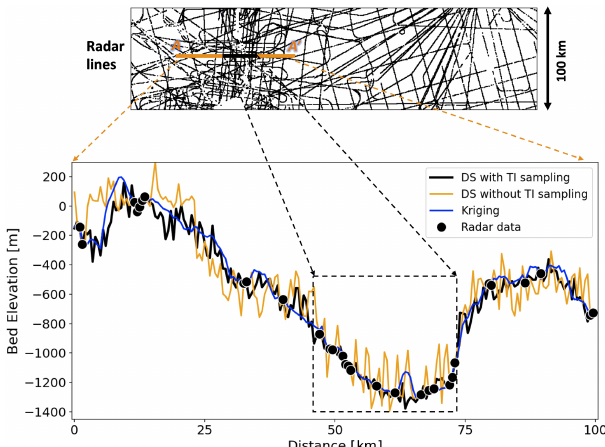
Figure 13. Cross-section view of the modelled topography maps at line A – A (cid:48) . The dashed black box shows main channel of Pine Island